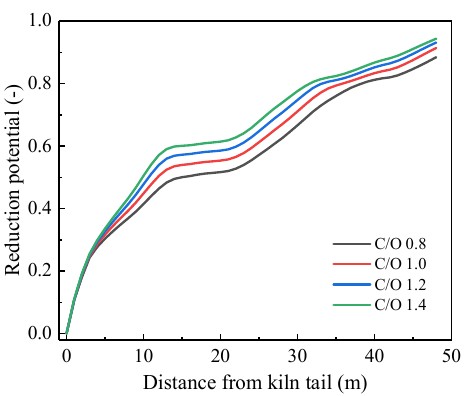
Figure 12. Reduction potential along the axial section for different C/O mole ratios.